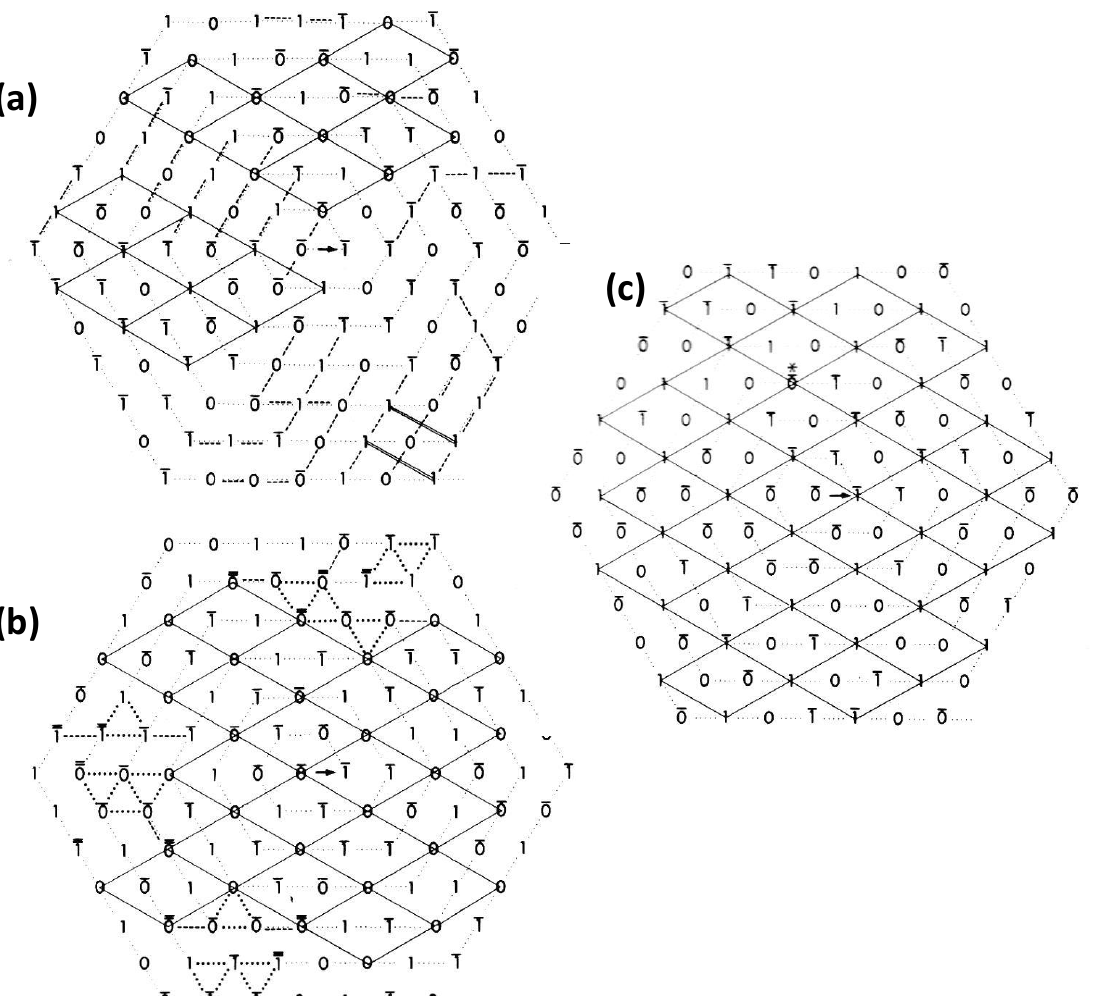
Figure 5. Generation of synthetic bare region model lattices using the no-three-alike rules: ( a ) rule 1 alone; ( b ) rule 2 alone; and ( c ) using rules 1 and 2 together. The lattices were generated in a spiral fashion as in Figure 4d. Superlattice unit cells are outlined by solid lines. Rule breaking is indicated by dotted and dashed lines. Filament orientations not determined by the rules have a line over the symbol. Filaments with forced breaking of the rules have a thick or double line over. ( c ) Shows more superlattice extent than ( a ) or ( b ), but even here the unit cell contents ( i.e. , the rotations of the filaments in the middle of the unit cells) vary across the lattice; there isn’t a regular structure. (Adapted from [18], with permission from